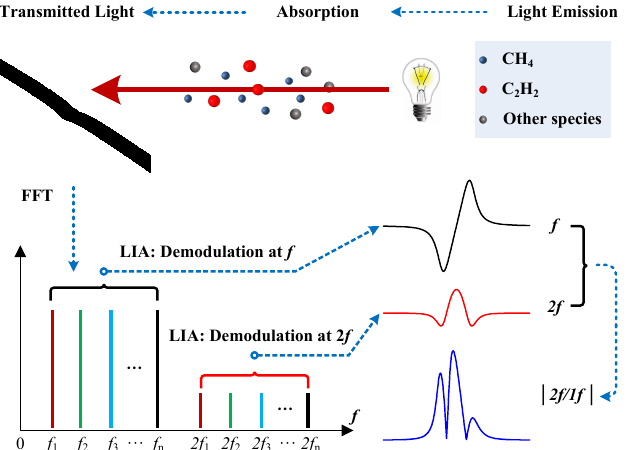
Figure 1. Schematic of the multi-species sensor combining normalized wavelength modulation spectroscopy and frequency-division multiplexing. f 1 , f 2 . . . f n equal the possible different modulation frequencies, and 2 f 1 , 2 f 2 . . . 2 f n represent the corresponding second harmonic positions in frequency domain. FFT: Fast Fourier Transform; LIA: Lock-in